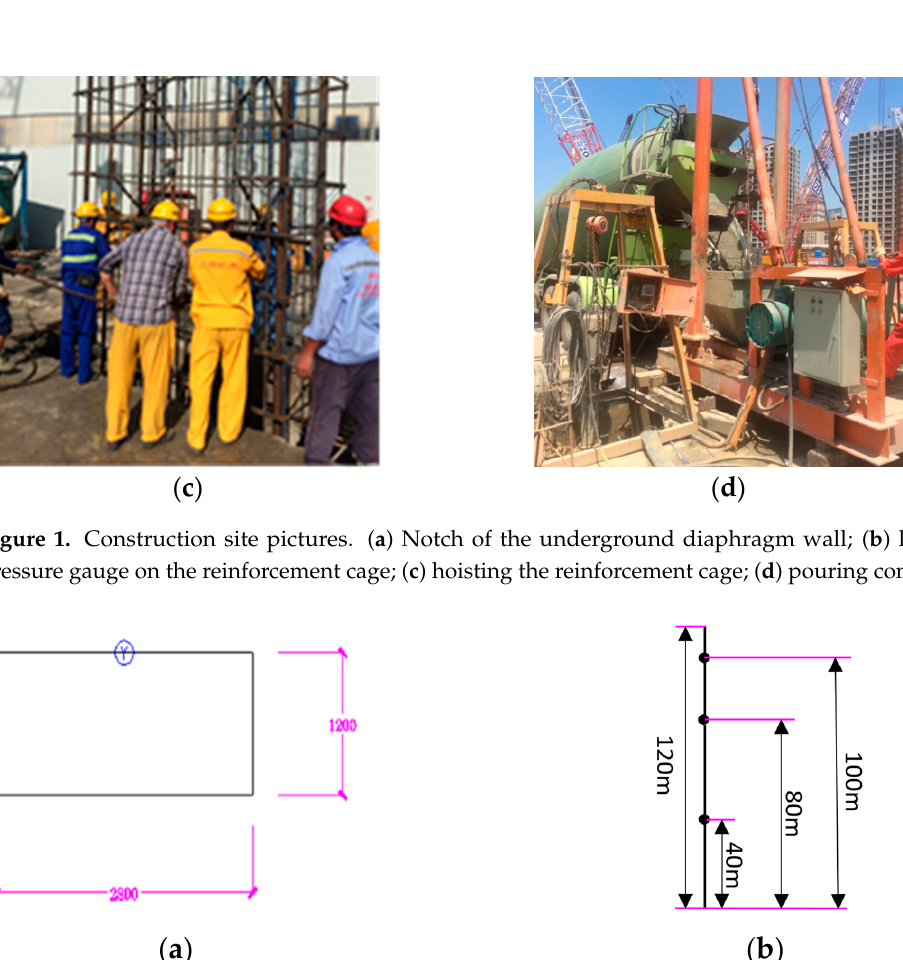
Figure 2. Diagram of pressure sensor locations. ( a ) Placement of pressure sensors on the cross section; ( b ) placement of the measuring instrument in the vertical direction.